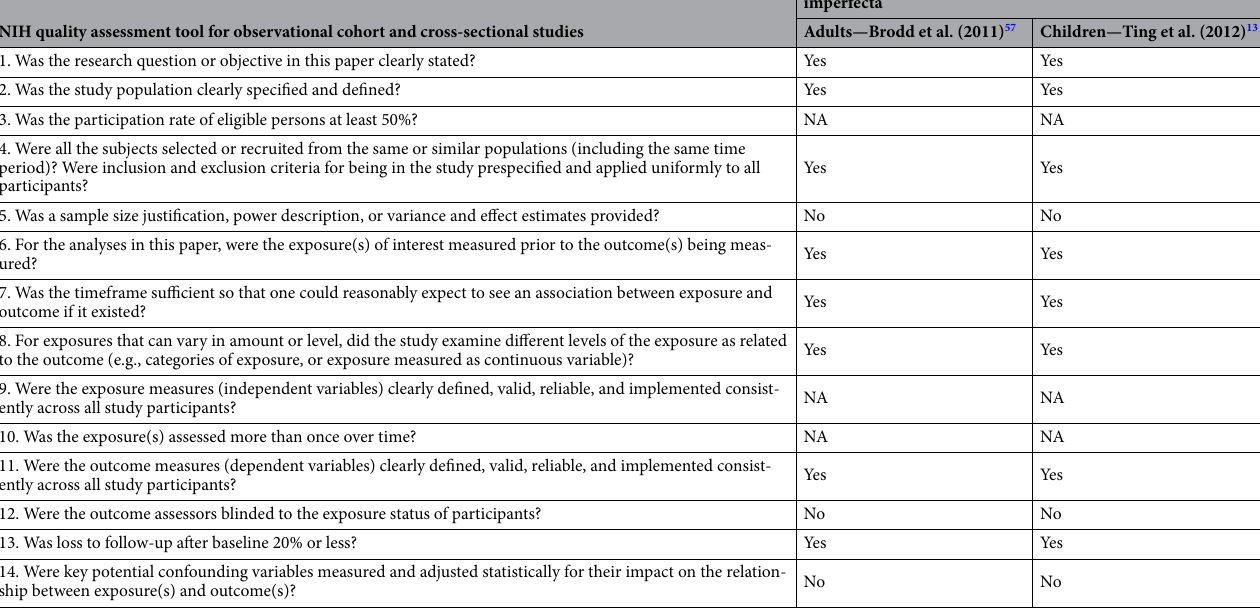
Table 5. Quality assessment tool for observational cohort and cross-sectional studies of the studies reporting on the effect of bisphosphonate on hearing loss in adults 57 , and children 13 with osteogenesis imperfecta. NA indicates not